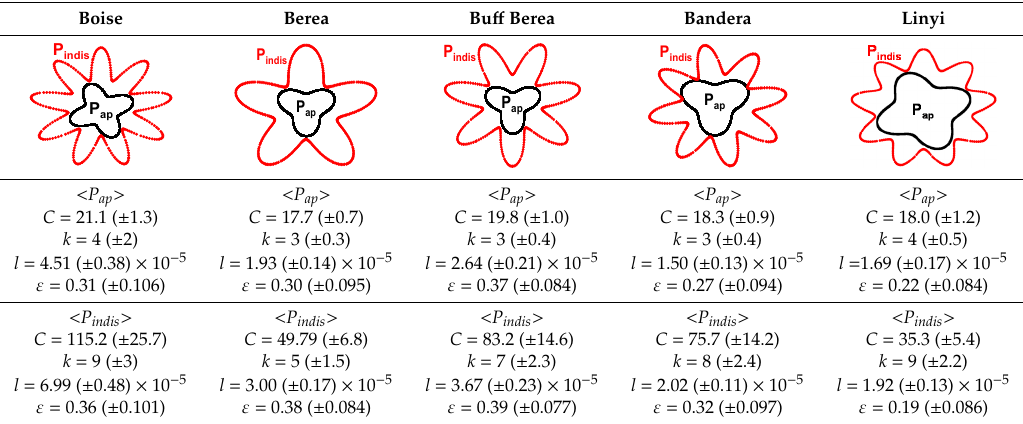
Figure 4. Flow chart to briefly describe the estimation process of representative pore geometry and example of perturbed cross-section. Table 3. Representative pore shape derived for each type of sandstone.